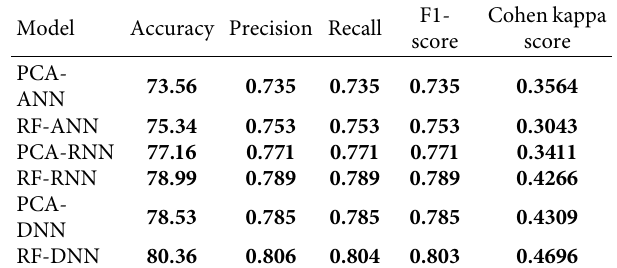
Table 6: Validation of the proposed model for 50 features.